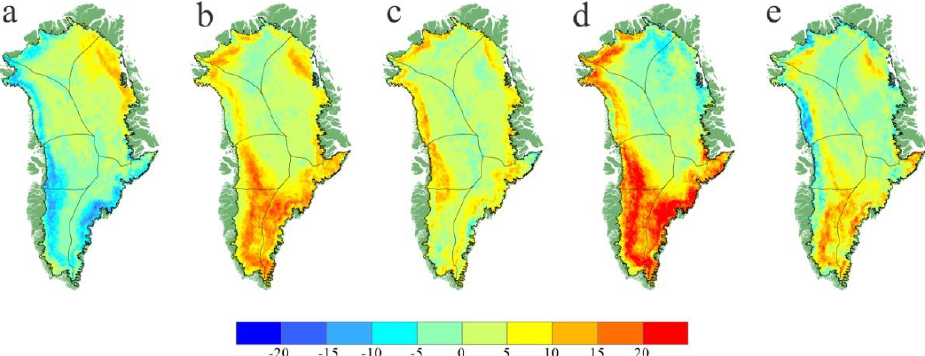
Figure 8. Melt-day anomaly for summer, 2002 ( a ), 2012 ( b ), and 2019 ( c ) compared to 2000 – 2020 summer mean. Difference in melt days between 2002, 2012 and 2019 (( d ): 2012 minus 2002, ( e ): 2012 minus 2019).